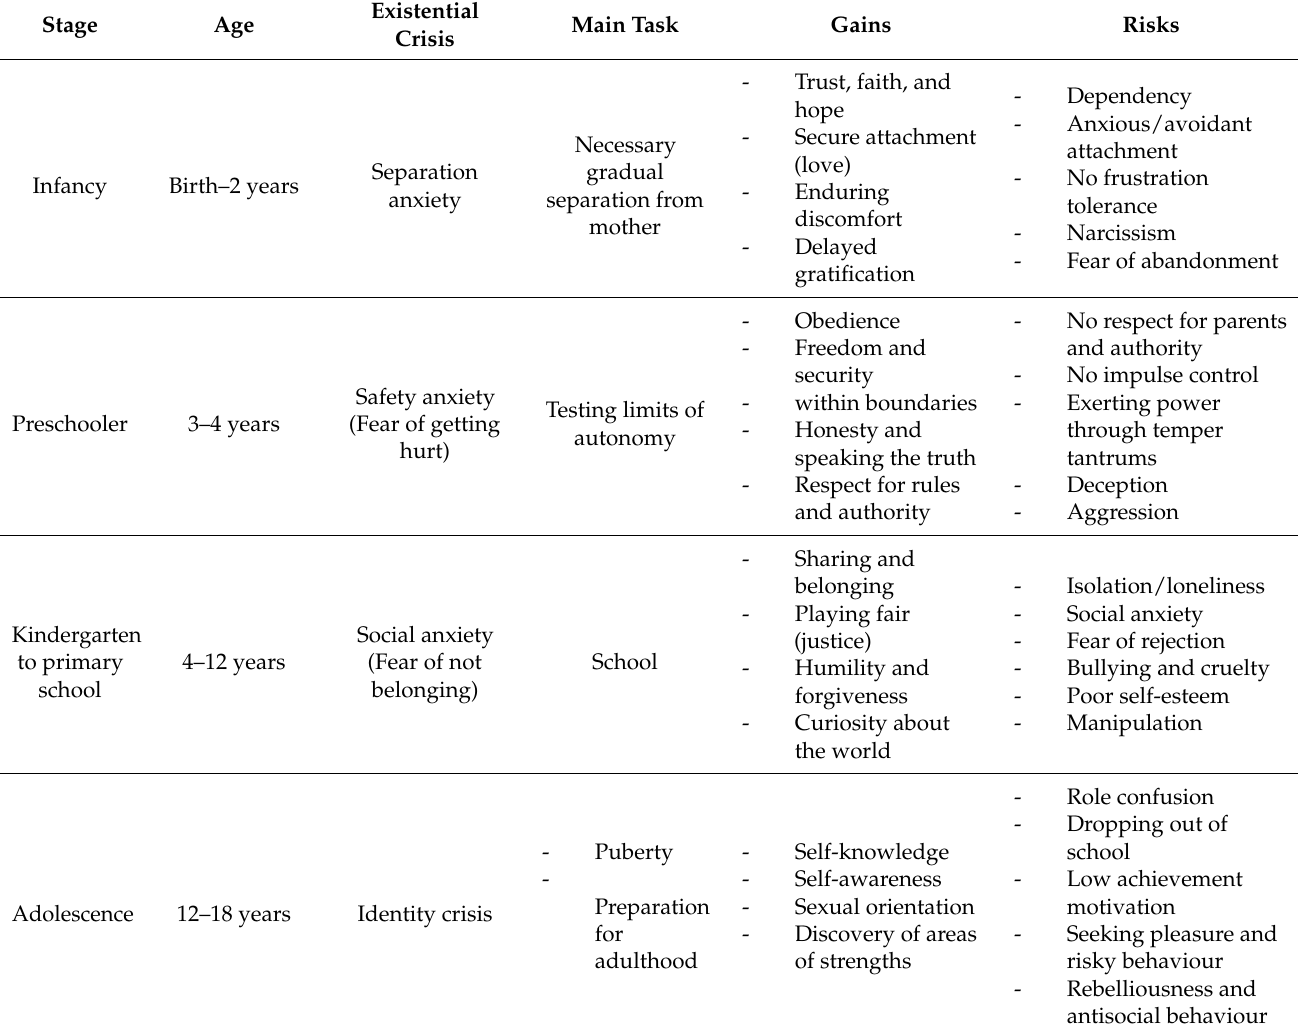
Table 1. Different Existential Crisis for Different Stages of Human